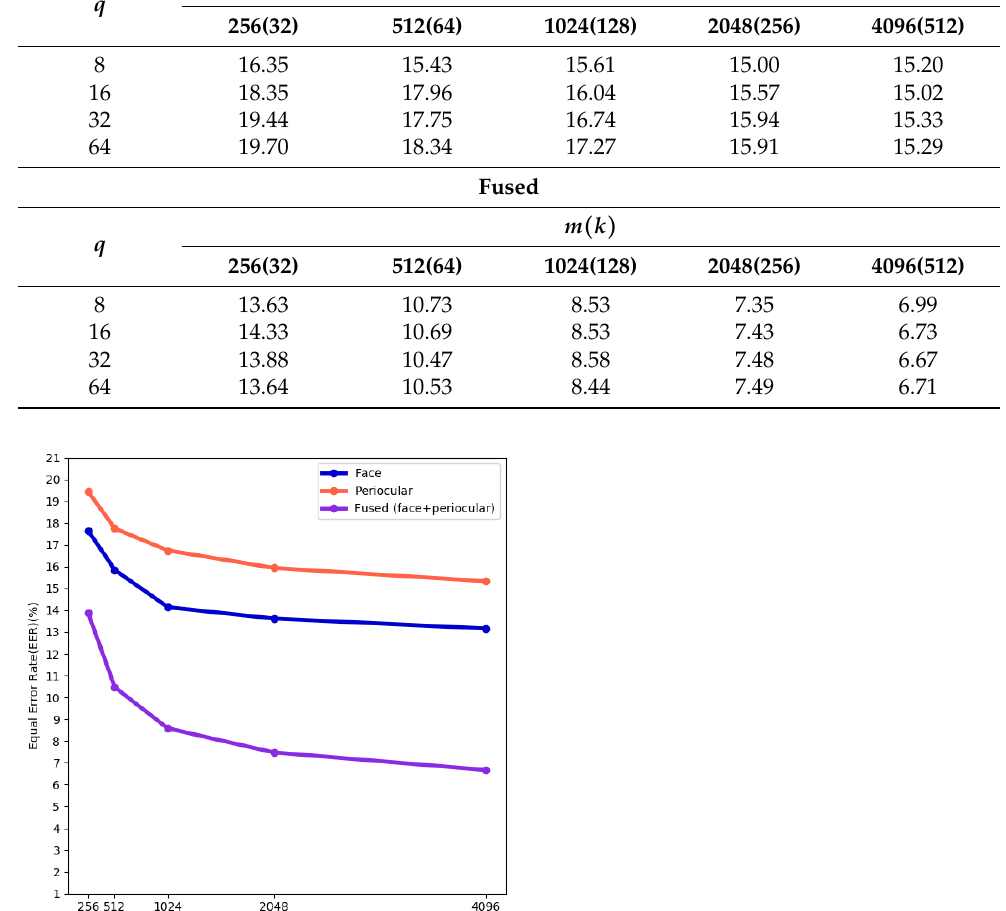
Figure 9. Average EER (%) for face, periocular, and fused biometric traits, for various m and q = 32.